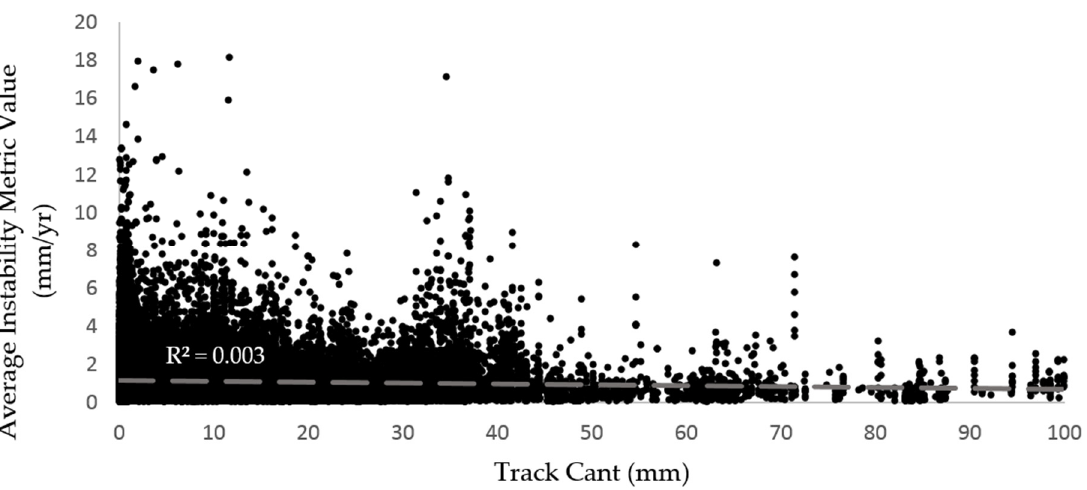
Figure 9. Graph of track curvature vs. embankment instability metric value.